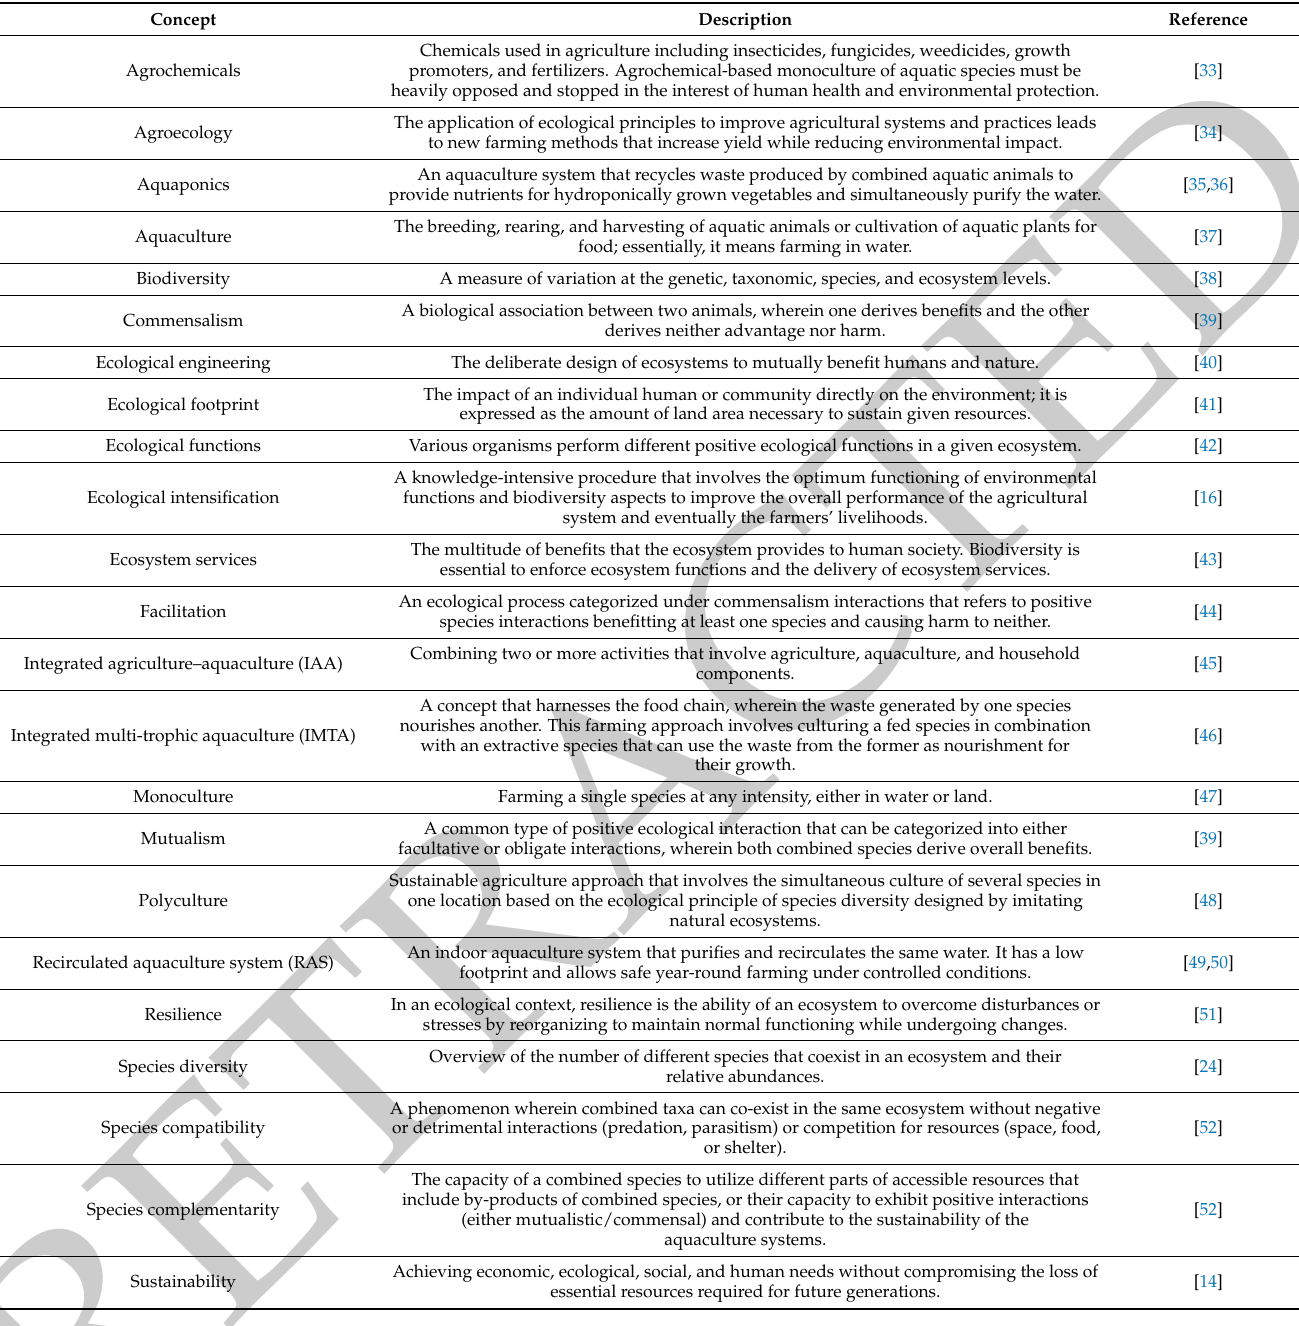
Table 1. List of glossary terms and aquaculture-related concepts used in the